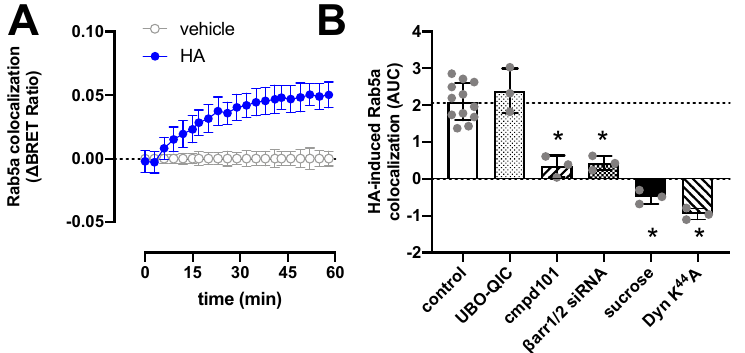
Figure 4. Histamine (HA)-induced internalization of H 1 R. BRET measurements in HEK293T cells transiently co-expressing H 1 R-Rluc8 (0.5 µg plasmid/dish) in combination with the early endosome marker Venus-Rab5a (2 µg plasmid/dish) in real time upon stimulation with 10 µM histamine ( A ). Data are shown as mean ± SD from at least three independent experiments performed in triplicate. Area under the curve (AUC) of 1-h BRET traces in response to 10 µM histamine following 30-min pretreatment of the cells with vehicle (control), 1 µM UBO-QIC, 3 µM cmpd101, or 0.16 µM sucrose, or co-transfection with dominant negative dynamin mutant K 44 A or β -arrestin1/2 siRNA. AUC of the BRET experiments are presented as mean ± SD from three independent experiments performed